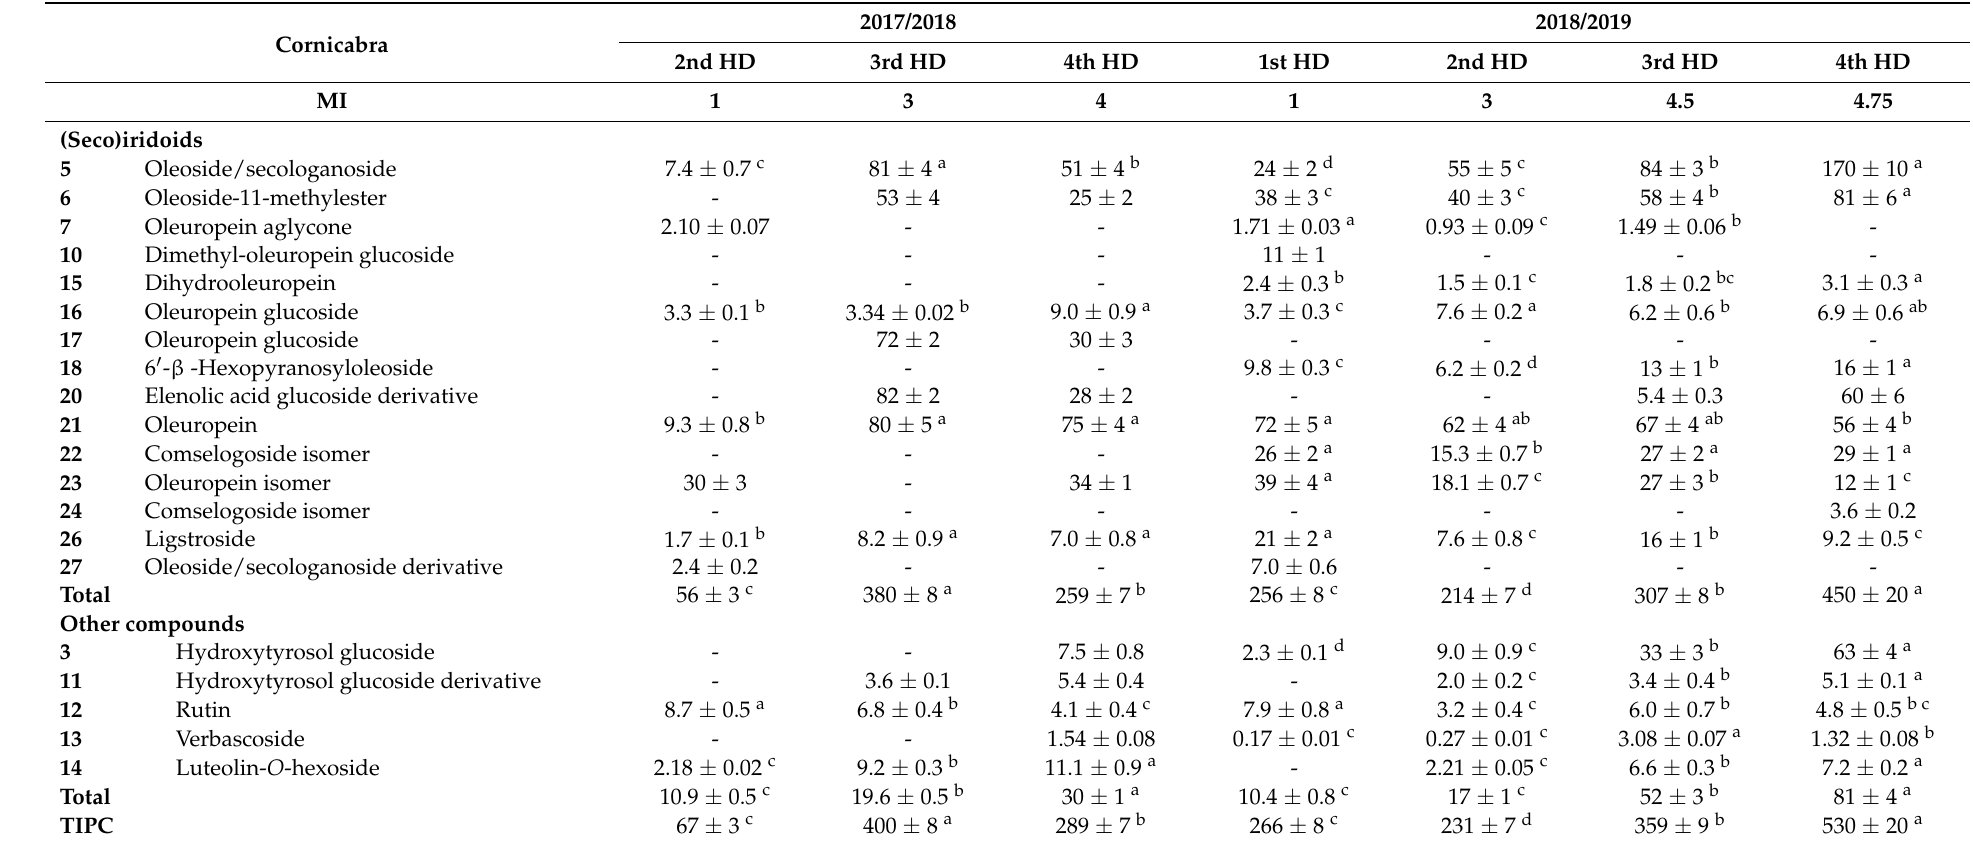
Table 3. Quantification of phenolic compounds in olive fruits (cv. Cornicabra) at different harvest times and harvest seasons.